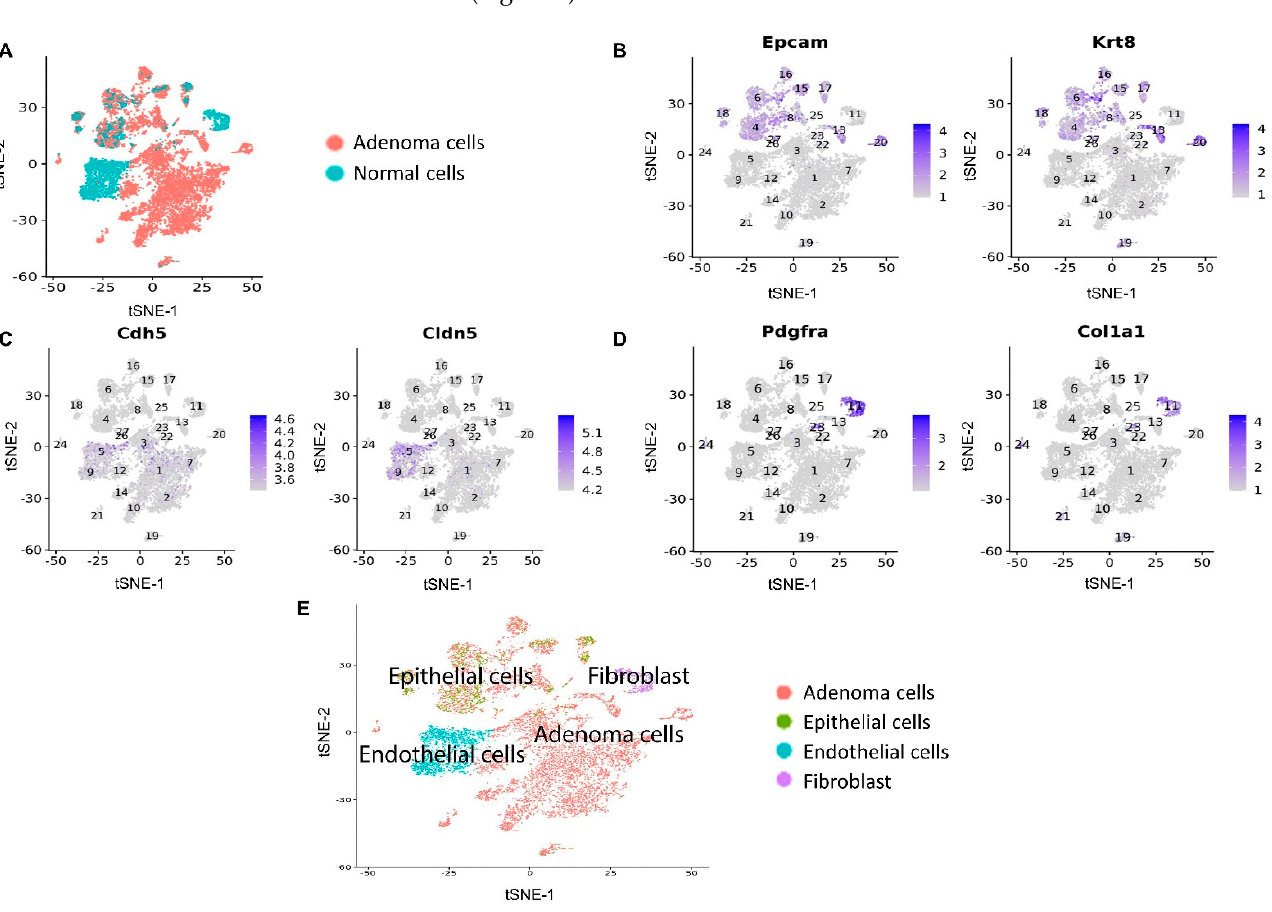
Figure 2. Clustering analysis of scRNA-seq data from CD45- flow-sorted lung cells from control and Mito-HNK groups. ( A ) Lung adenoma cells were identified using scCancer software. Marker gene expression for ( B ) epithelial cells, ( C ) endothelial cells, and ( D ) fibroblasts. ( E ) Annotation of CD45- cells into the four identified cell populations.